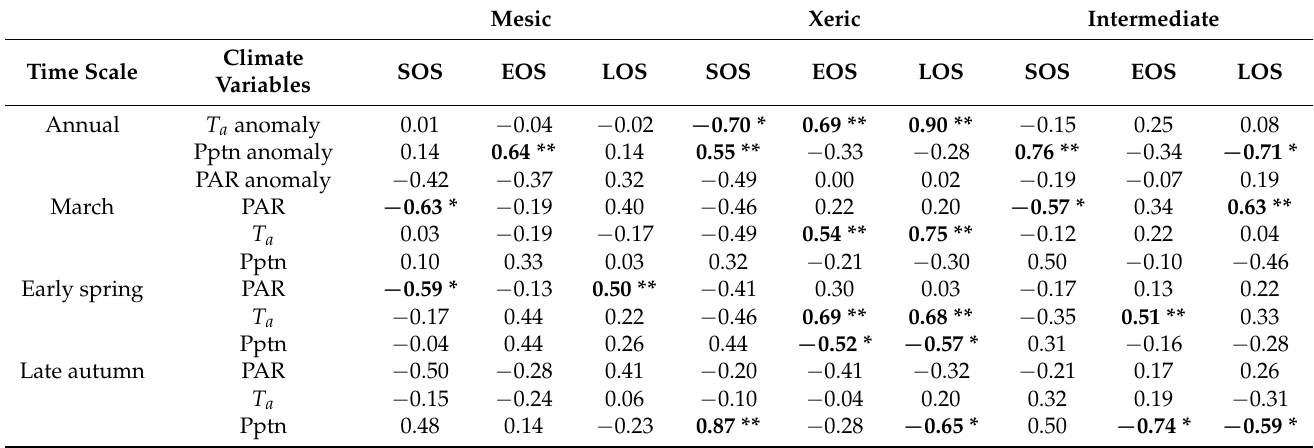
Table 4. Spearman correlation coefficients relating start of growing season (SOS), end of growing season (EOS) and LOS (length of growing season) to interannual, March, early spring (January to March), and late autumn (October to November) air temperature ( T a ), PAR and cumulative precipitation (Pptn) anomalies (mm) by site. T a ( ◦ C) and PAR ( µ mol m − 2 s − 1 ) were estimated as averages, precipitation as